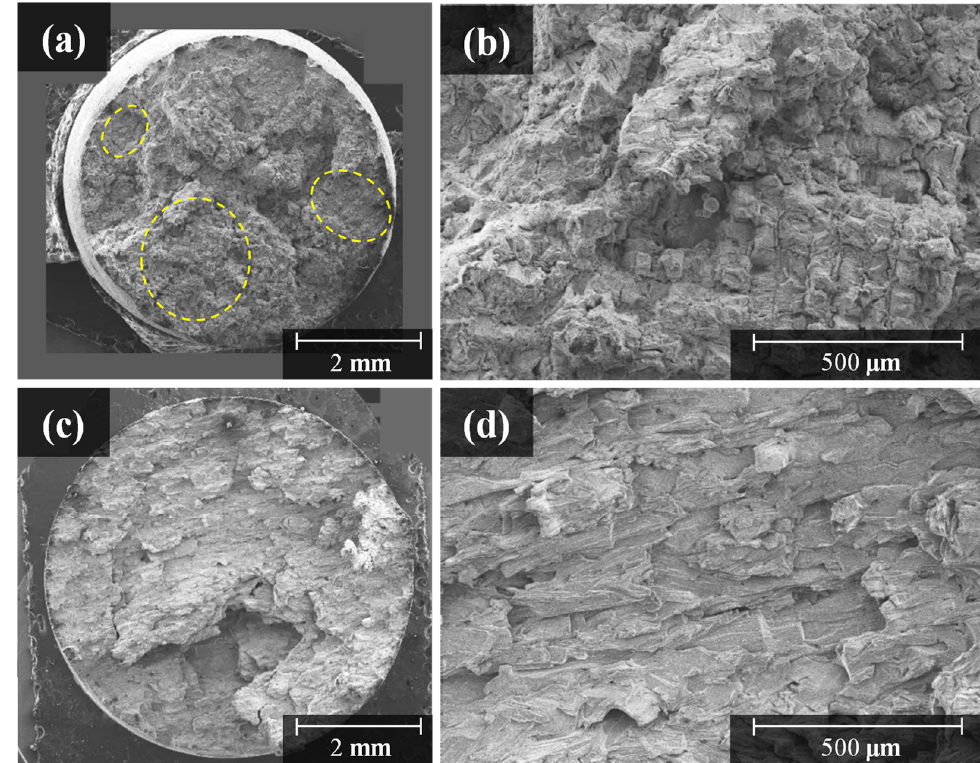
Figure 12. Creep fracture surface characteristics of Hastelloy X specimens fabricated with different deposited direction: ( a , b ) are stacked vertical LPBF as-built specimens; ( c , d ) are stacked horizontal LPBF as-built specimens.